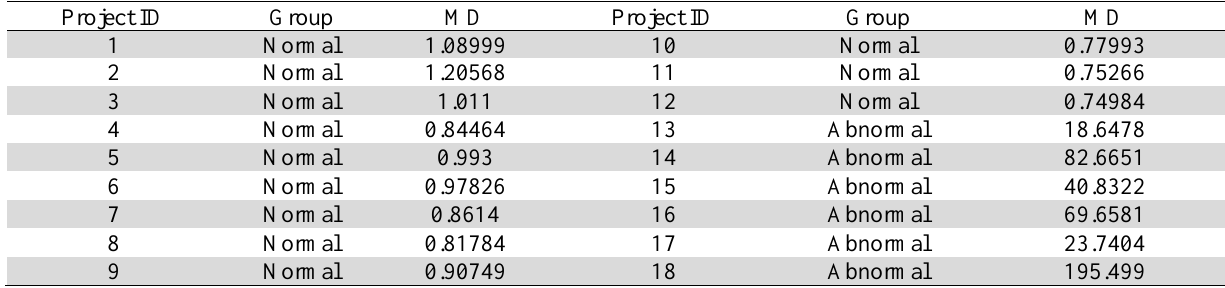
Mahalanobis distance values Project